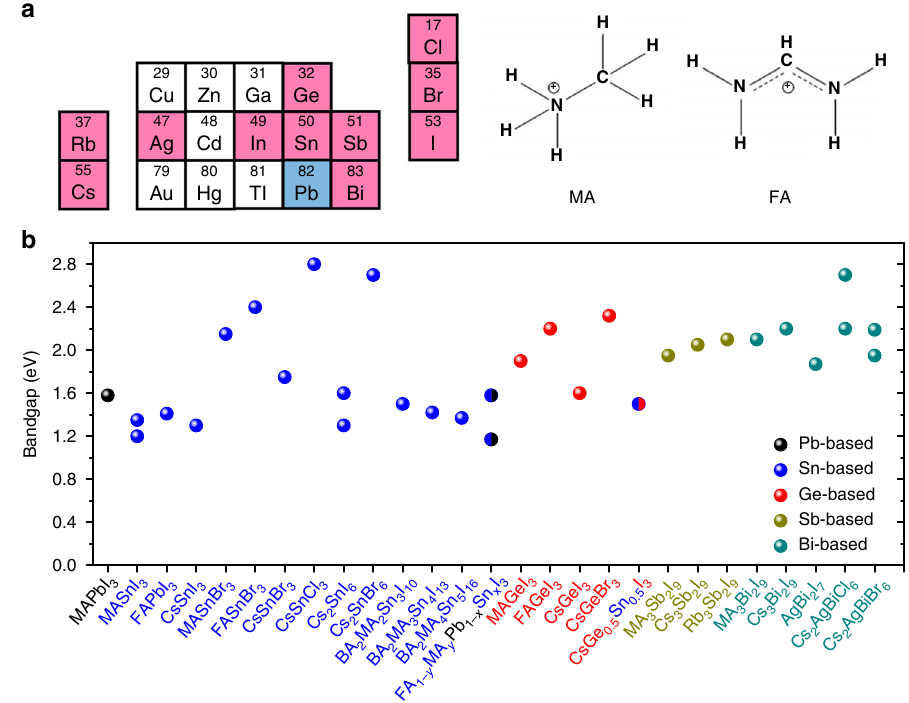
Fig. 1 Potential materials as solar cell absorbers. a Potential A-site cations (organic MA and FA or inorganic Cs and Rb), metals, and halides (I, Br, Cl) for perovskite structure. b Bandgaps of various materials 4,6,8,9,18,19 . The suitable materials for solar cells should have direct bandgaps of around 1.1 to 2.0